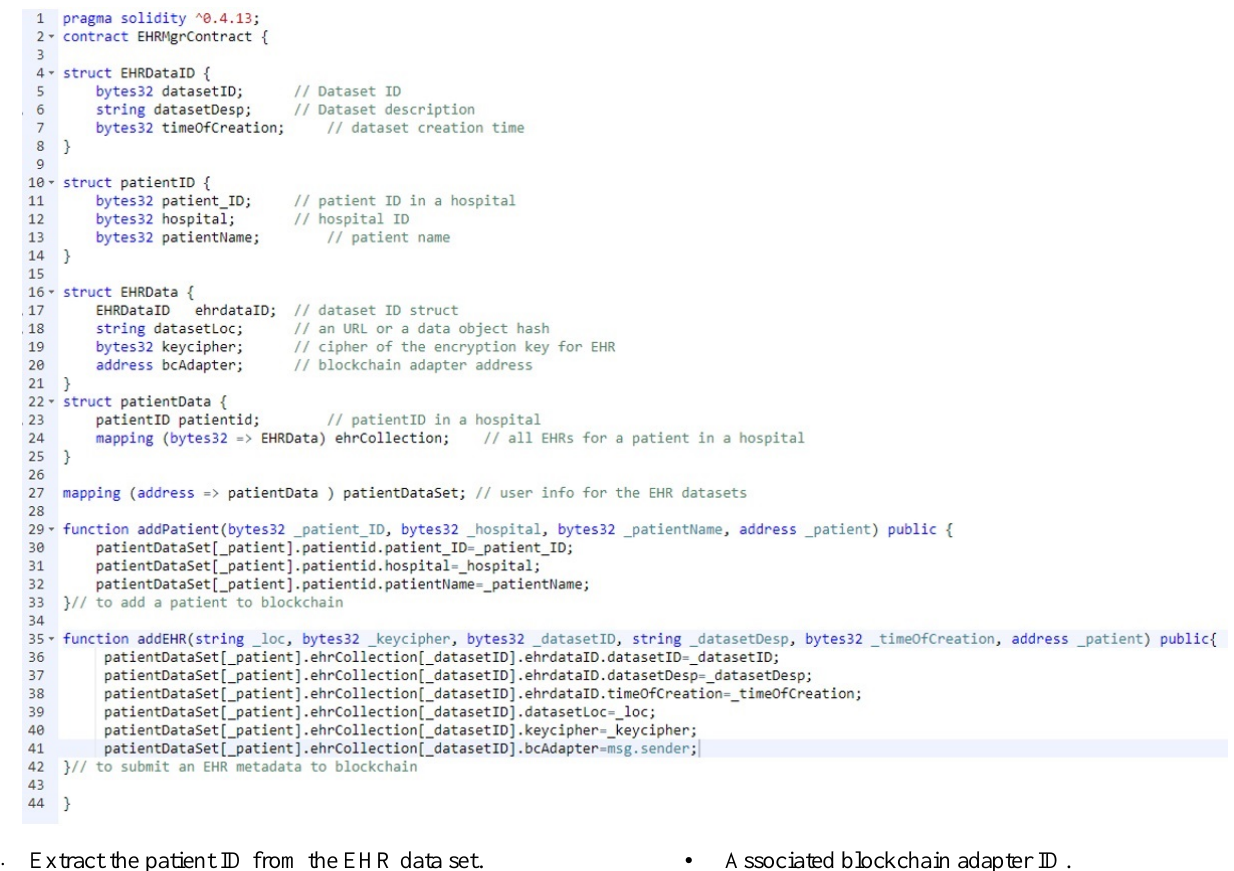
Figure 2. Main part of the electronic health record manager smart contract code that defines the metadata structure. Blockchain adapters must extract the information and calculate the encrypt keys and then store them into the smart contract. The record will automatically associate with the adapter’s blockchain